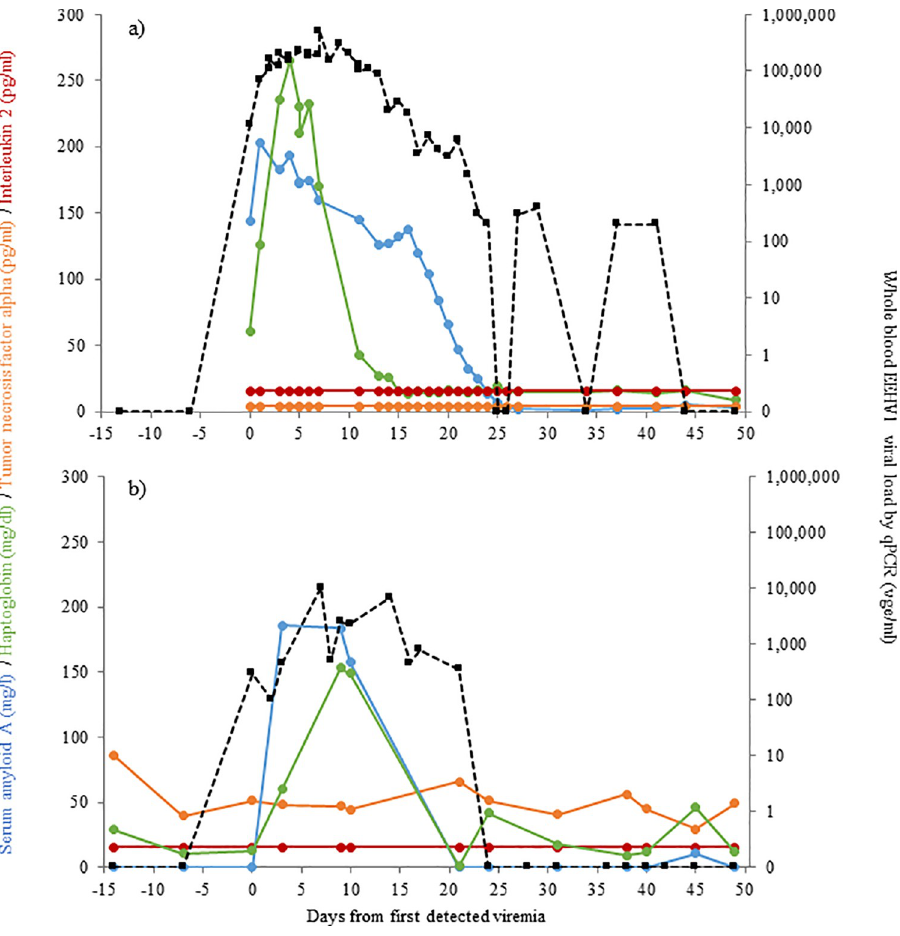
Fig 4. Biomarker concentrations during EEHV1 viremia in two female Asian elephants aged 4 y 8 m (a) and 11 y 11 m (b).